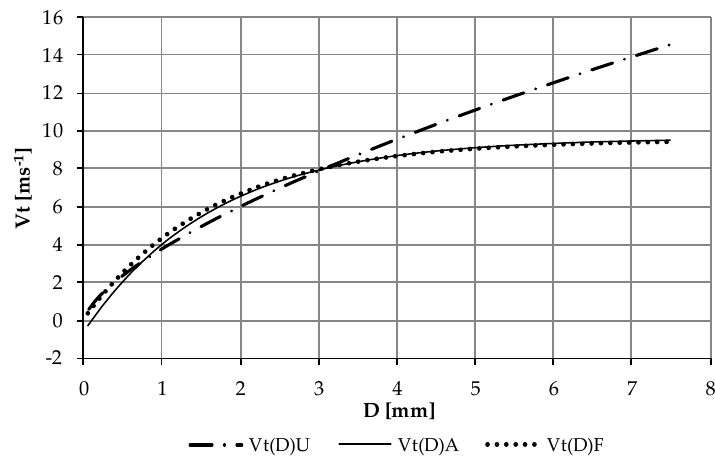
Figure 4. Terminal velocity against drop diameter resulting from the three formulations proposed by Ulbrich [47], Atlas et al. [48], and Ferro [50].